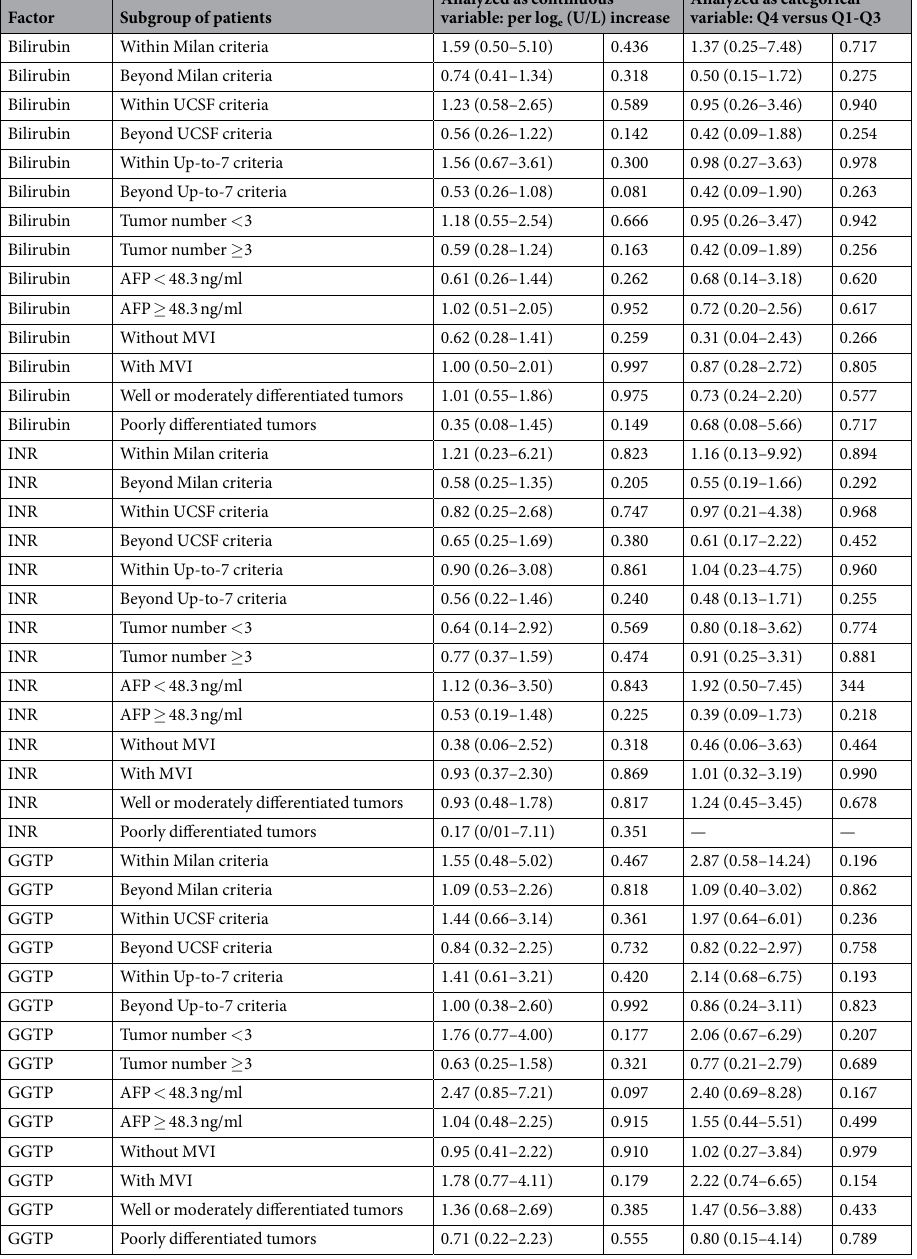
Table 8. Subgroup analyses of the associations between peak 7-day postoperative bilirubin concentration, INR value, and GGTP activity and the risk of hepatocellular carcinoma recurrence after liver transplantation according to fulfillment of selection criteria and independent risk factors. Hazard ratios for continuous variables are given per: 1 mg/dL increase for bilirubin concentration; 1 increase for INR; 1 log e (U/L) increase for GGTP activity. Q4 – fourth quartile; Q1-Q3 – first to third quartile; INR – international normalized ratio; GGTP – gamma-glutamyl transpeptidase; AFP – alpha-fetoprotein; MVI – microvascular